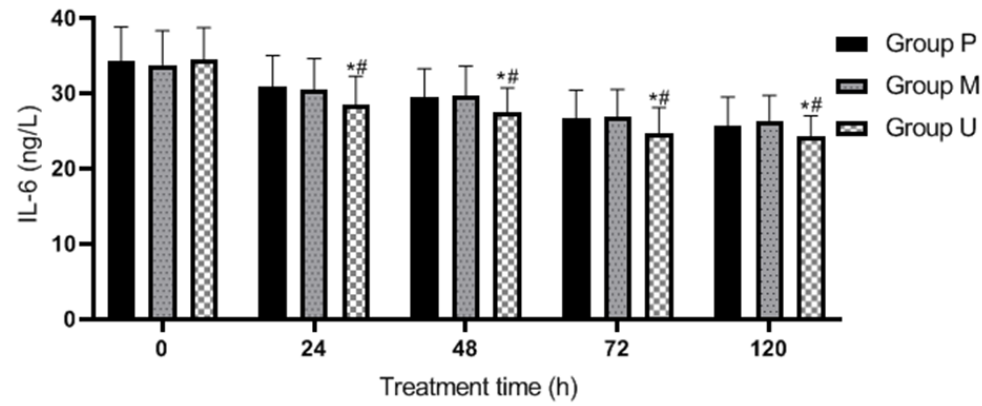
FIGURE 2 - Comparison of IL-6 levels among the three groups at different treatment times.